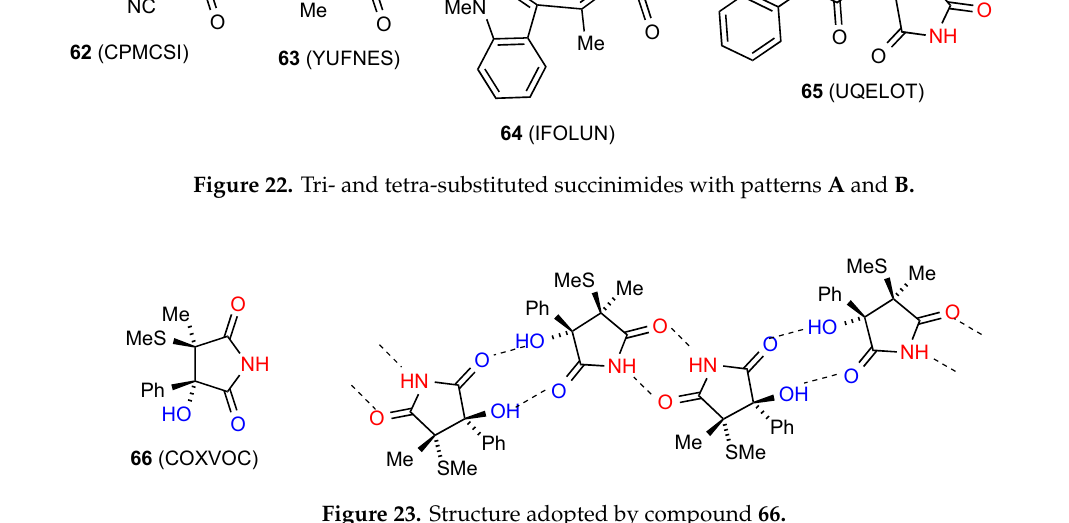
Figure 22. Tri- and tetra-substituted succinimides with patterns A and B.